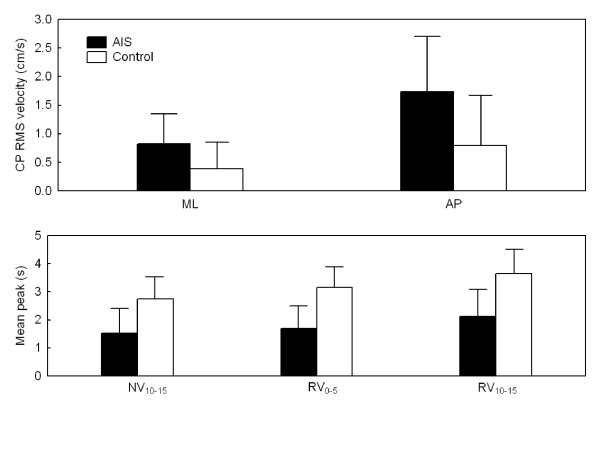
Balance control performance during reintegration of vision. Upper panel – Group means for the CP RMS velocity along the medio-lateral (ML) and antero-posterior (AP) axes for the proprioception/no-vision to proprioception/reintegration vision condition. Lower panel illustrates the interaction Group by Epoch for the time spent within the zones of stability (mean peak) for the last 5 s epoch of the proprioception/no vision interval (NV10–15) and first 5 s epoch (RV0–5) and last 5 s epoch (RV10–15) of the proprioception/vision reintegration intervals. On both panels, the error bars indicate 95% confidence intervals.